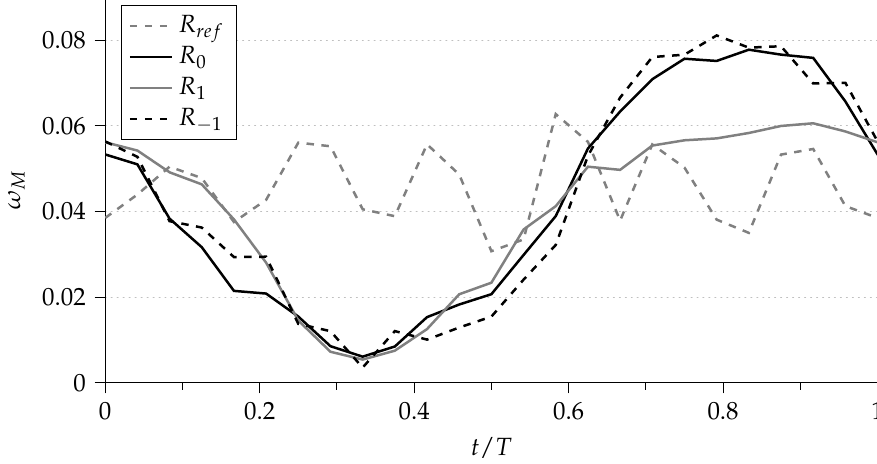
Figure 9. The variation of the mixed-out losses ω M for one bar passing